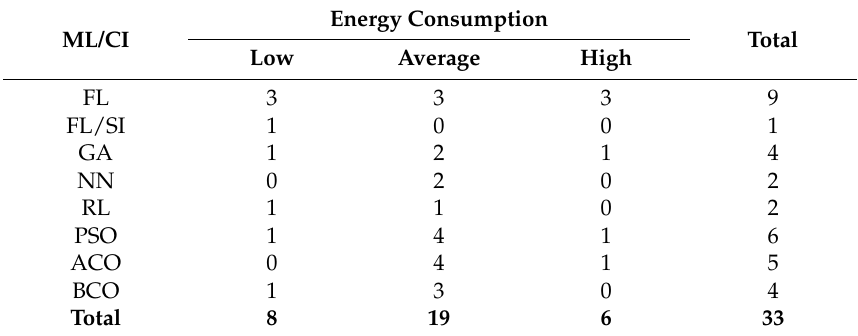
Table 1. Comparison of CI’s approaches according to the energy